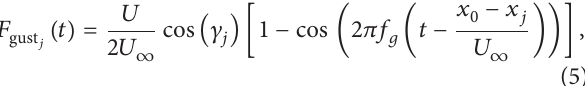
expressed in (5) (discrete gust 1 – cosine model for a reference system with 𝑧 upward and 𝑥